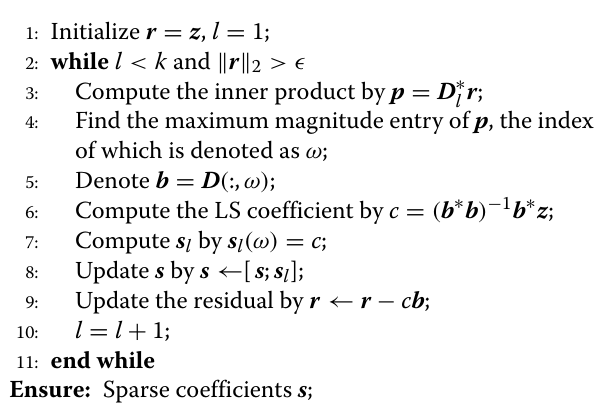
Algorithm 1 Sparse recovery for CK-SVD